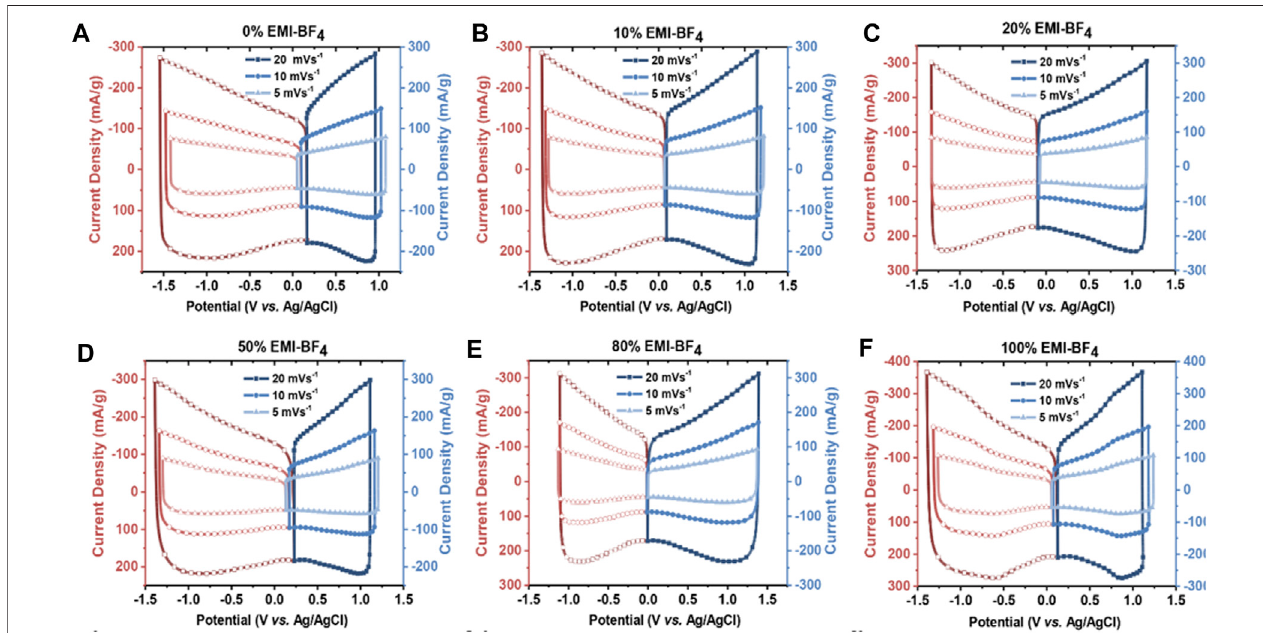
FIGURE 5 | Cyclic voltammograms for cells assembled with (EMIM)(Tf 2 N) and (EMIM)(BF 4 ) mixture with different volumetric percentages of (EMIM)(BF 4 ), including (A) 0%, (B) 10%, (C) 20%, (D) 50%, (E) 80%, and (F) 100%. Operating potential window in all cases is 2.5 V and rates are 5, 10, and 20 mVs − 1 . Reprinted with the permission from (VanAken et al., 2015), Wiley Online